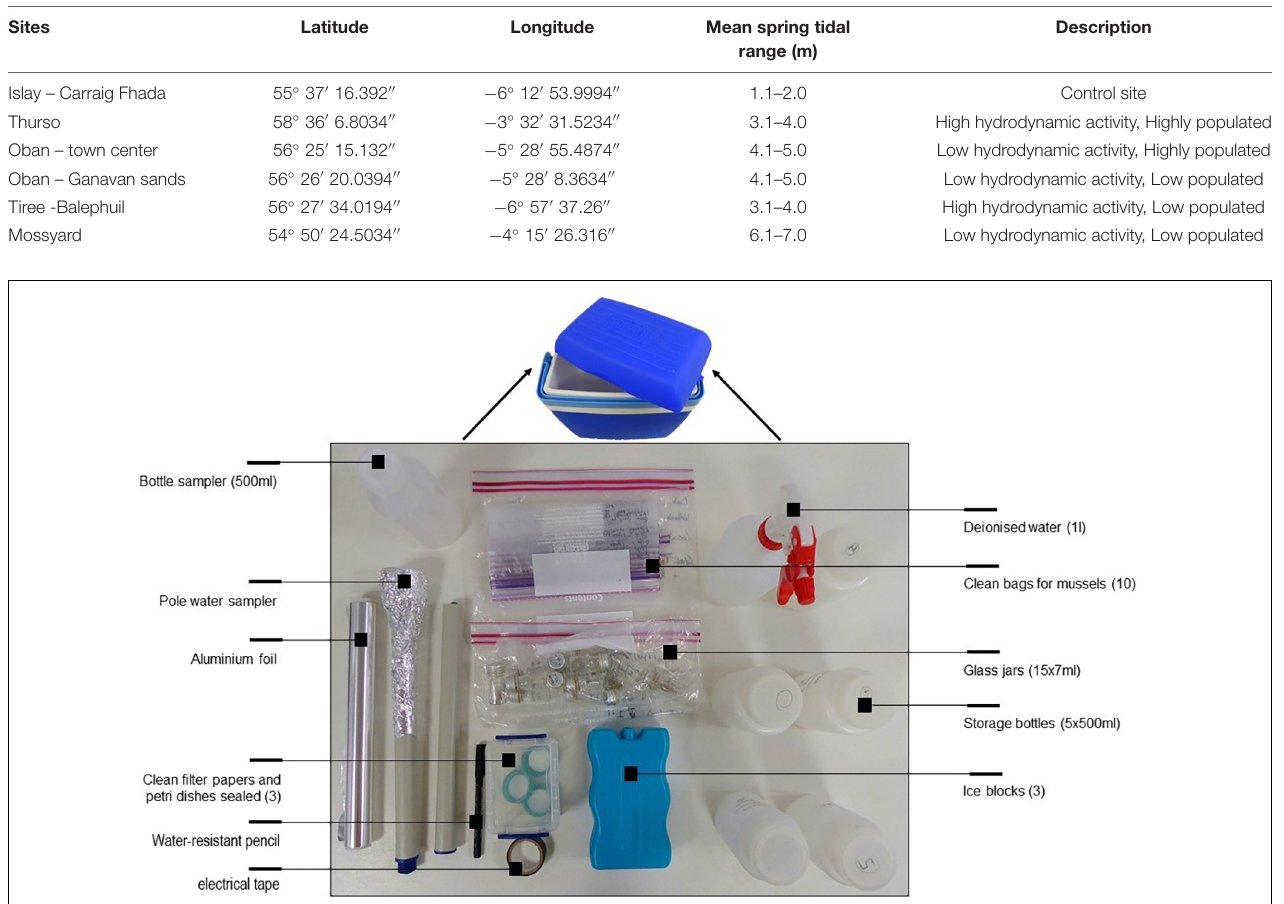
FIGURE 2 | Sampling tool-kit compiled before sending the cool-box to citizen